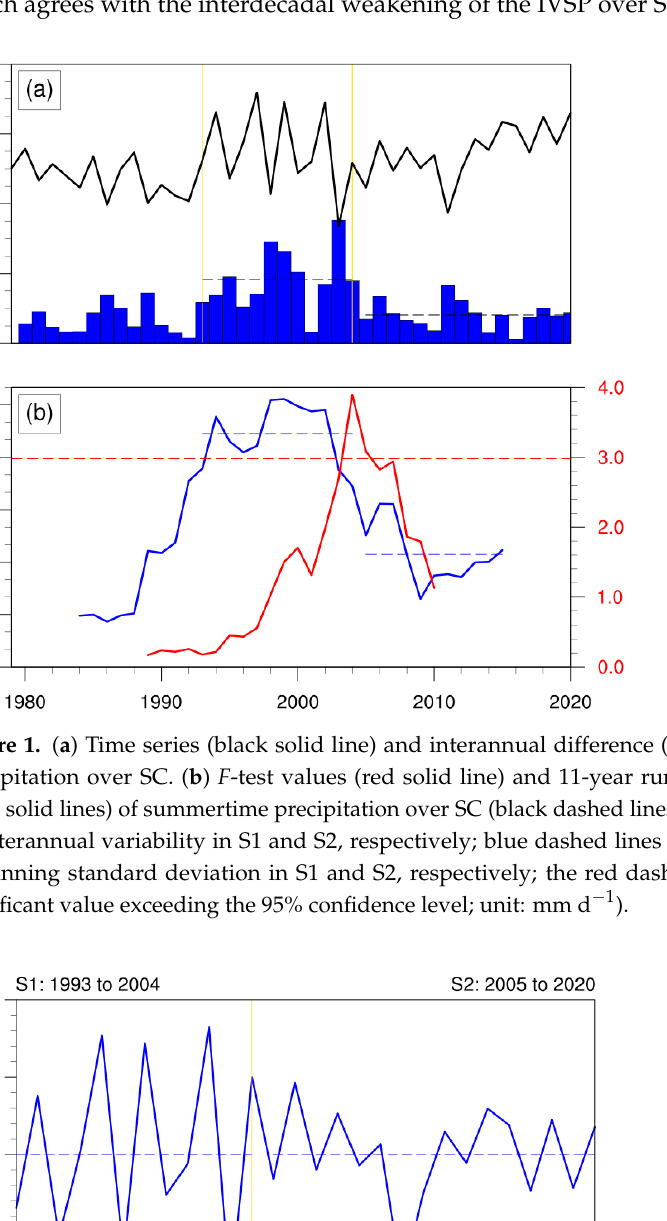
Table 1. Wet and dry years picked out in S1 and S2 based on the detrended summertime main precipitation larger and smaller than 0, respectively.